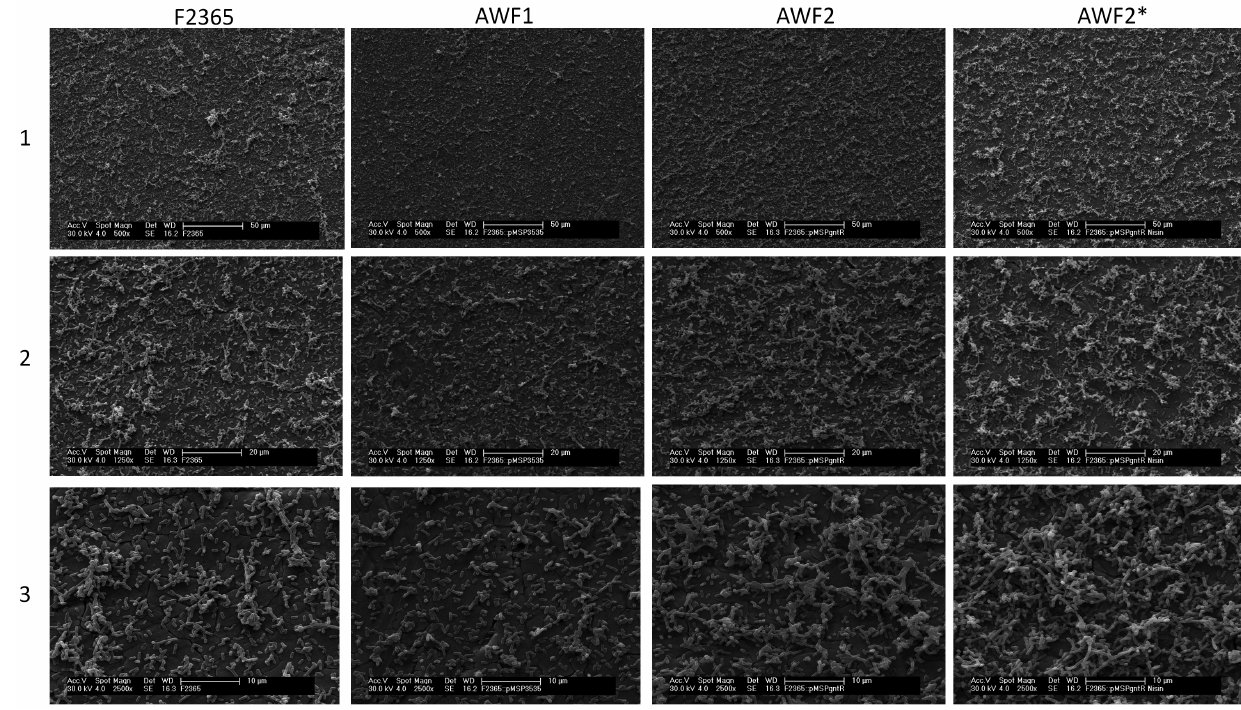
Figure 3. Listeriamonocytogenes biofilms by SEM. Listeria strains include F2365, AWF1, AWF2 without nisin (AWF2), and AWF2 in the presence of nisin (AWF2*). Micrographs were taken at magnifications of 500x (1), 1250x (2), and 2500x (3).